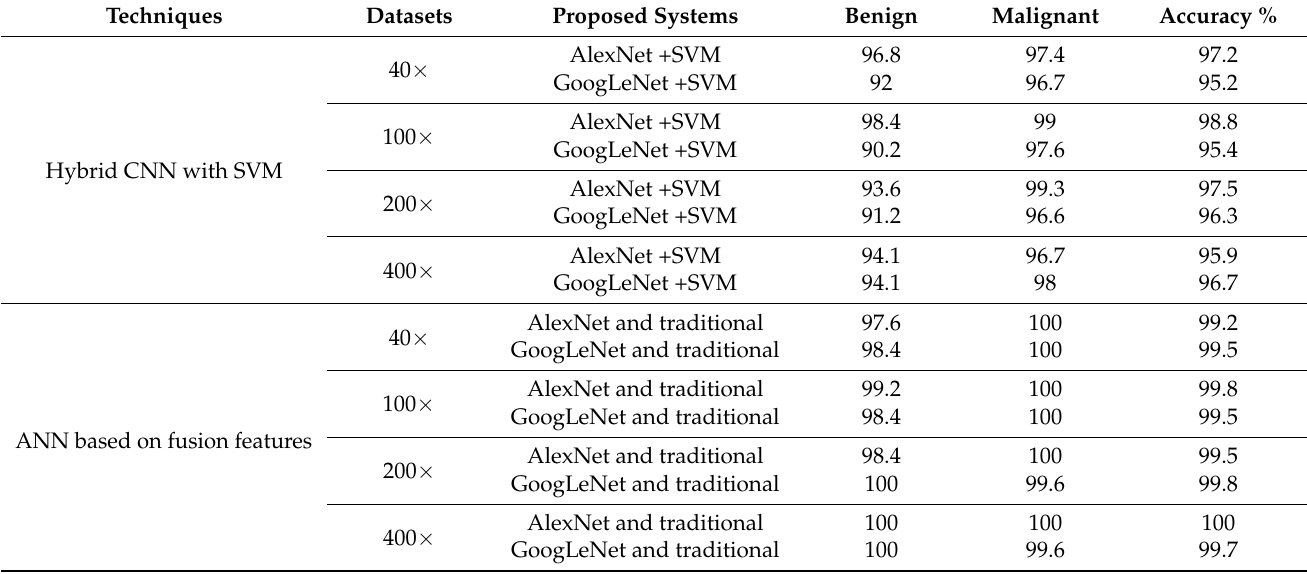
Table 7. Accuracy for each class achieved by all proposed methods for diagnosing HI of the BC datasets with